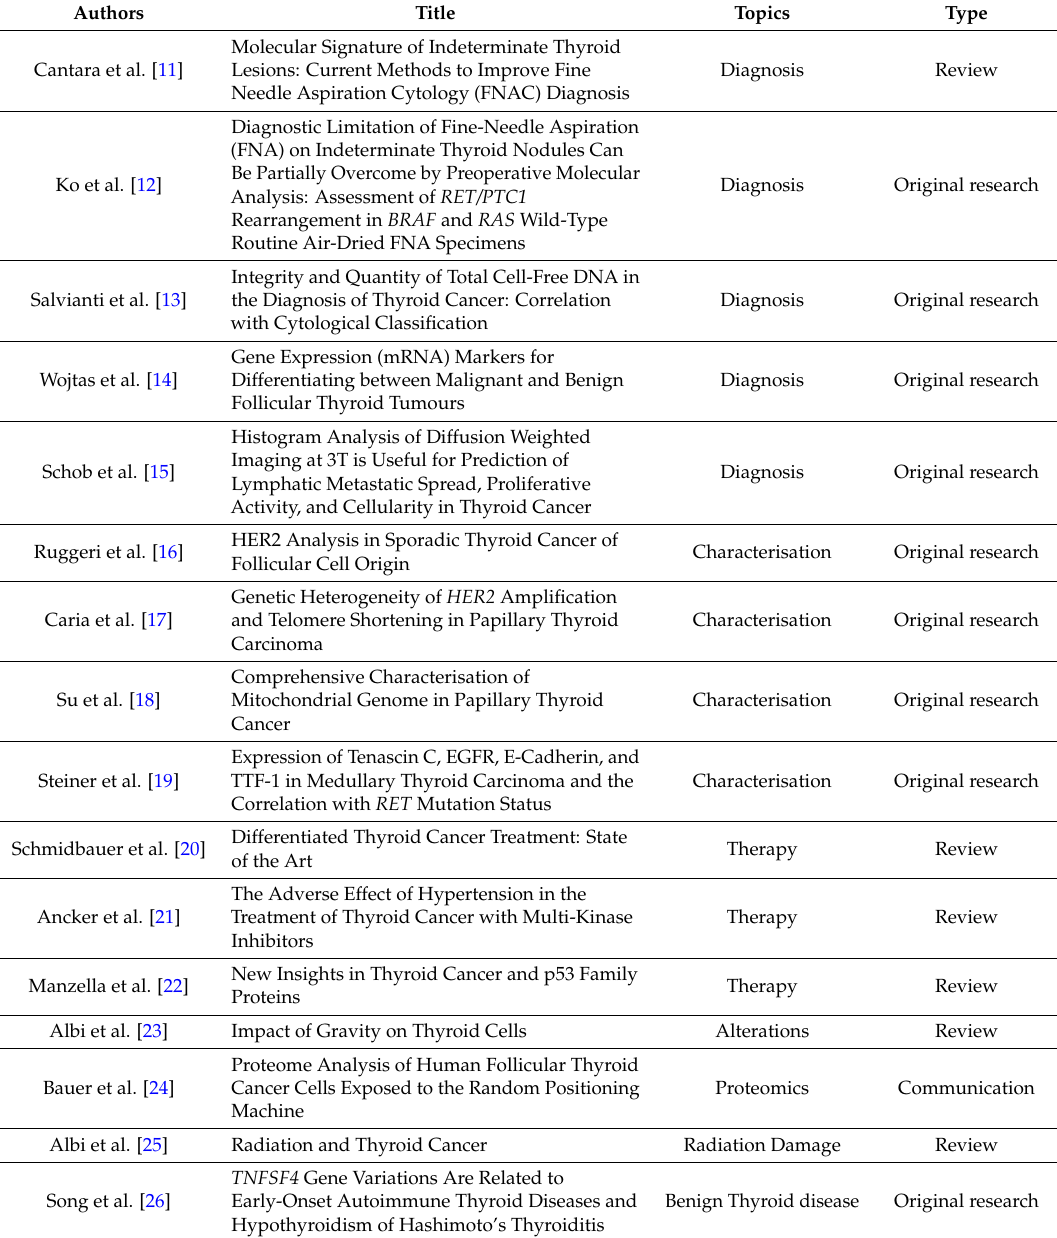
Table 1. Contributions to the Special Issue “Current Knowledge in Thyroid Cancer—From Bench to